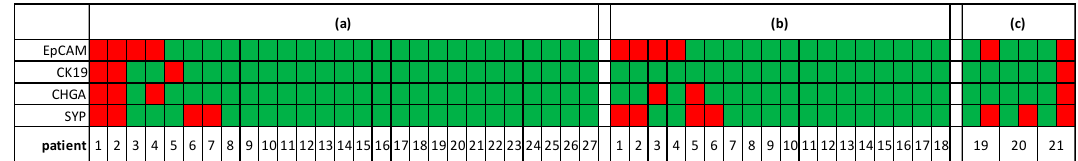
Figure 3. Heat map for EpCAM , CK19 , CHGA , and SYP in the 51 microfluidic enriched blood samples of patients with small ‐ cell lung cancer. (a) Twenty ‐ seven samples were taken at diagnosis, (b) 18 samples were taken at progression/recurrence, and (c) displays serial blood draws taken from three patients during disease progression. Red and green squares indicate positive and negative gene expression per tested sample, respectively.